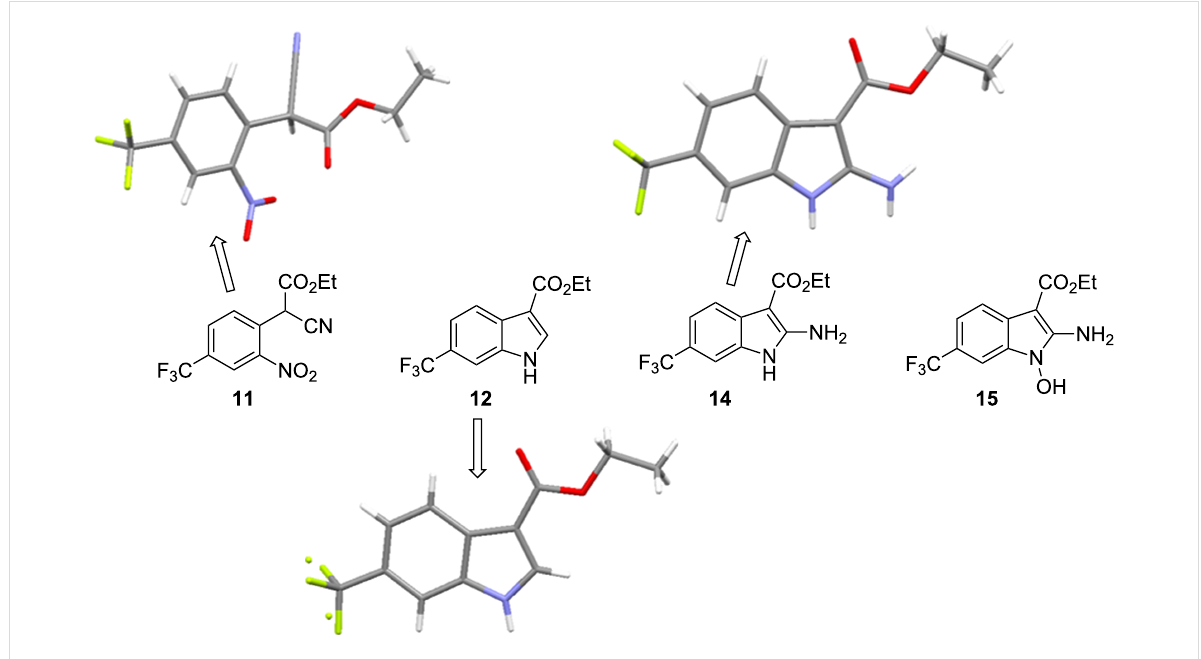
Figure 2: X-ray structure of intermediate 11 , and reductive cyclisation products 12 and 14 , assigned structure of byproduct 15 .